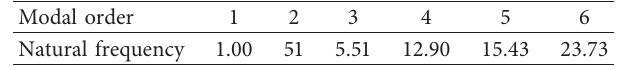
Table 1: The first 6 dimensionless frequencies of the cantilever plate.